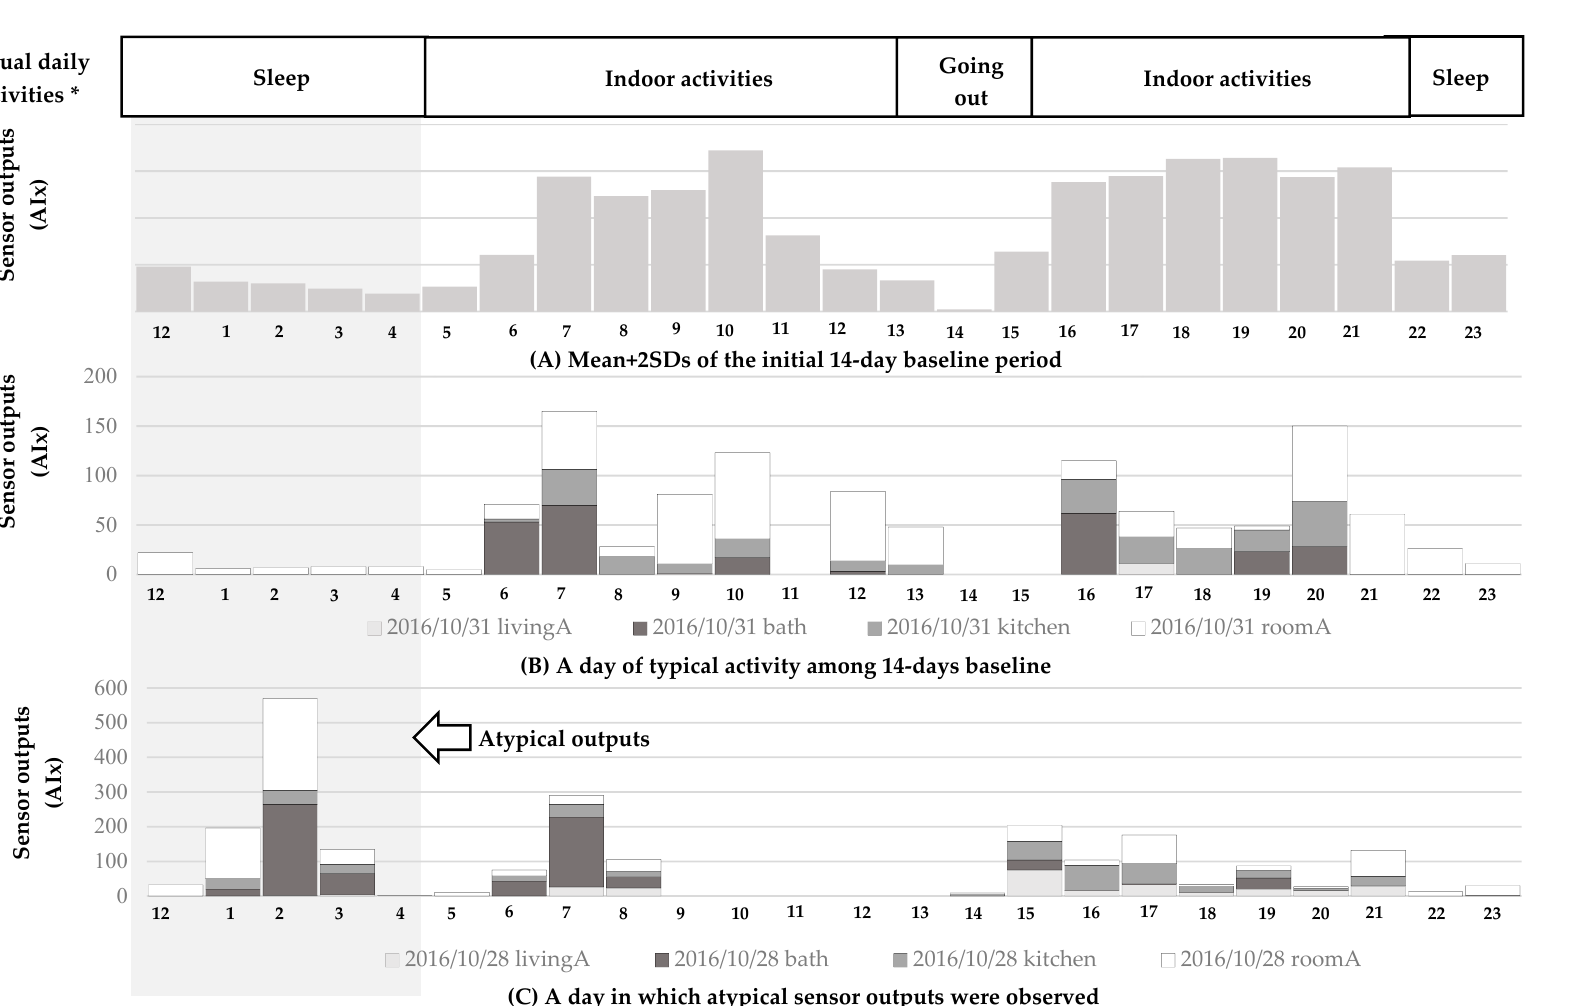
(C) A day in which atypical sensor outputs were observed Figure 3. A typical sensor output of Participant E (F / Figure 3. A typical sensor output of Participant E (F/81-years-old).